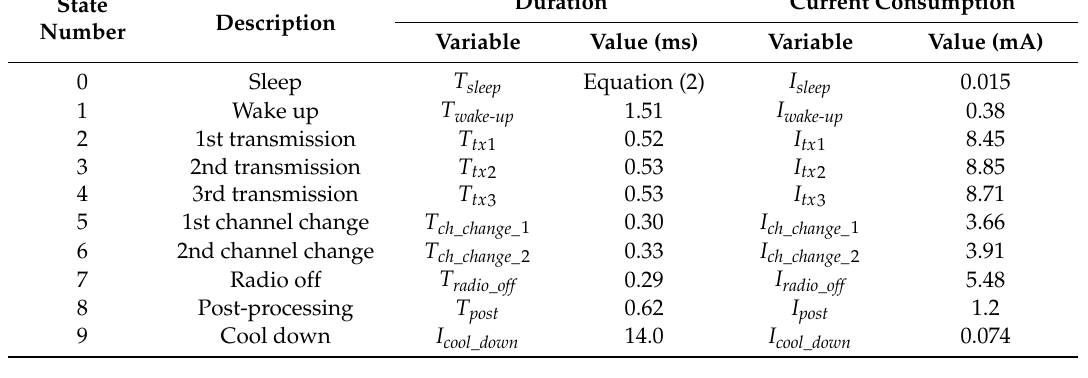
Figure 6. Current consumption of an nRF51422 Development Kit for the different states related with the transmission of three advertisements. Table 1. Characterization of the states related with the transmission of three advertisements by an nRF51422 Development Kit.